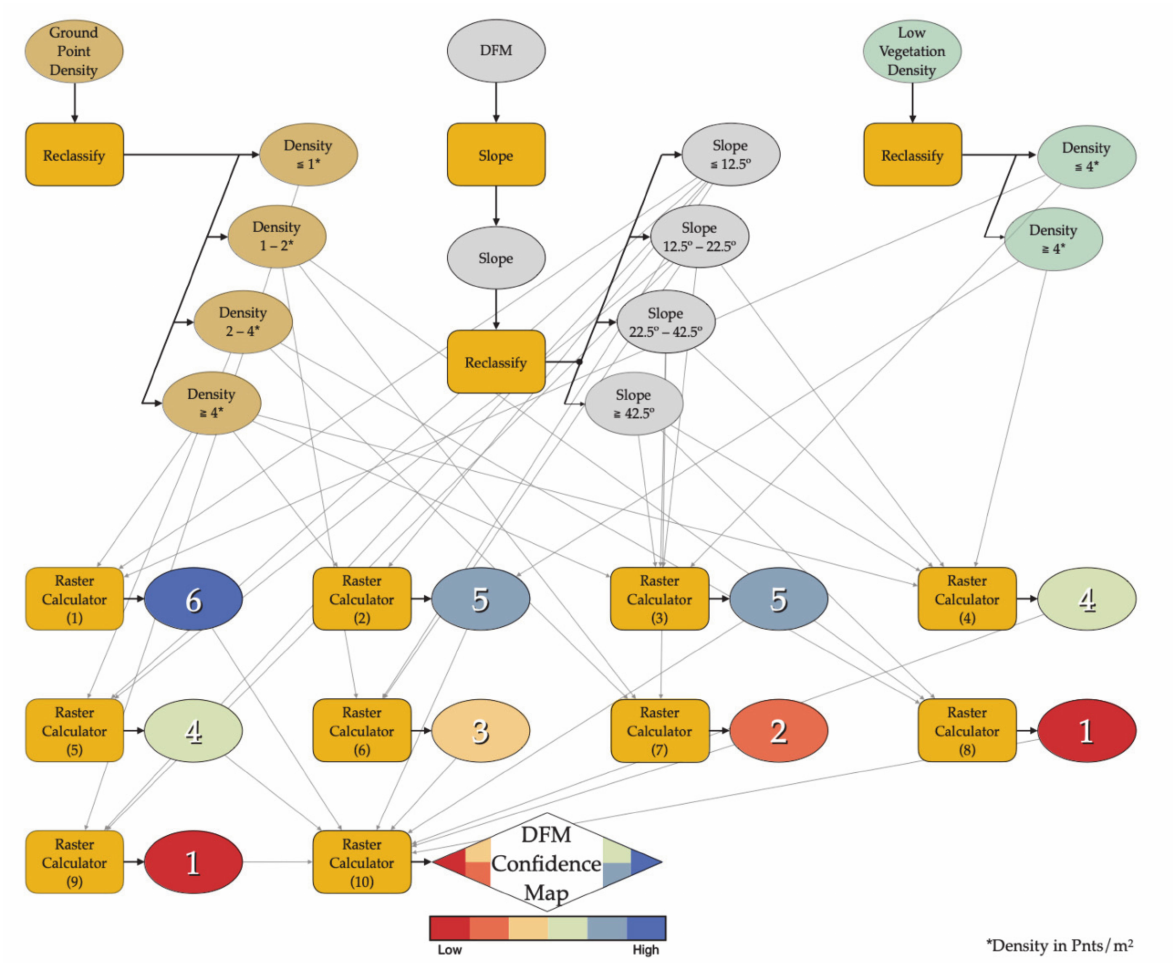
Figure 8. DFM confidence map algorithm for a 0.5 m DFM confidence map (after [32]: Figure 4; published under CC-BY